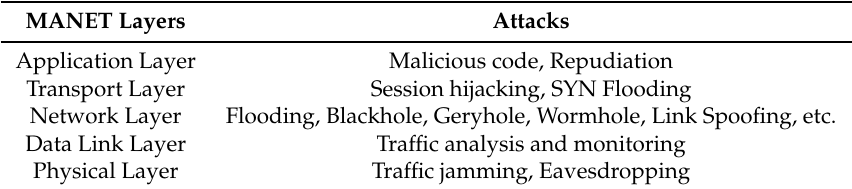
Table 1. Example Attacks in Different Network